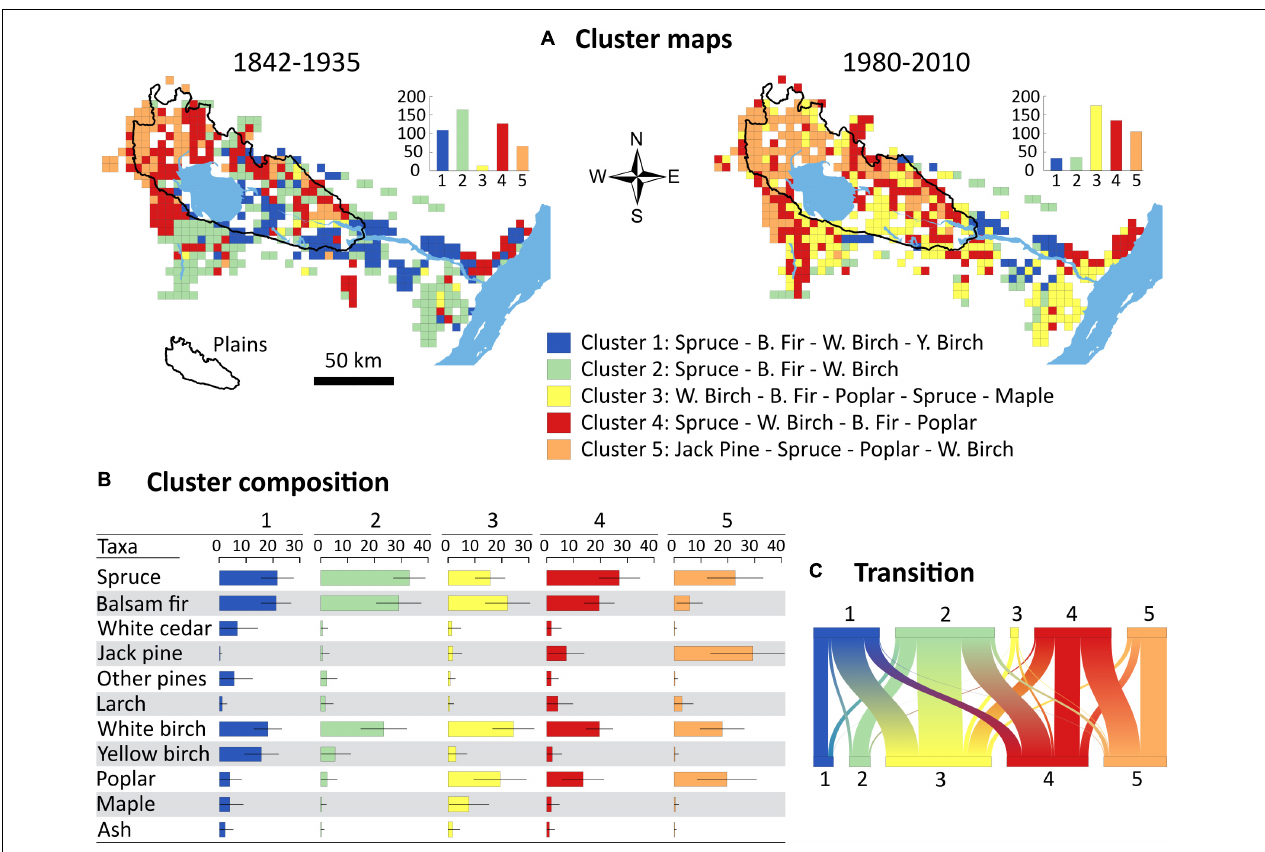
FIGURE 4 | Landscape tree assemblages identified by hierarchical clustering of the 25-km 2 grid cells. (A) Maps of the clusters for the two time periods with histograms showing the number of cells in each cluster; (B) Table of cluster composition showing taxon mean relative frequency and standard deviation (bars); (C) Transition among clusters from pre-settlement (top) to modern (bottom) periods. The width of each box is proportional to the corresponding number of cells.